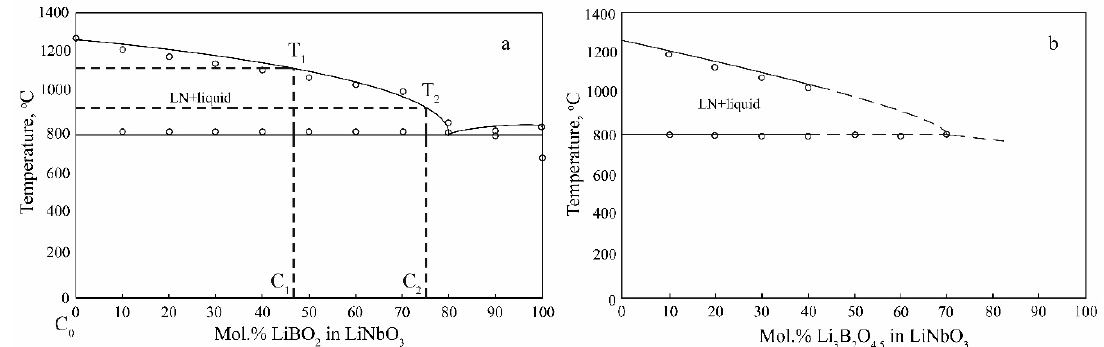
Figure 12. Polythermal sections of the state diagram of a quasi-ternary system Li 2 O–Nb 2 O 5 –B 2 O 3 : LiNbO 3 –LiBO 2 ( a ), LiNbO 3 –Li 3 B 2 O 4.5 ( b ) [73].